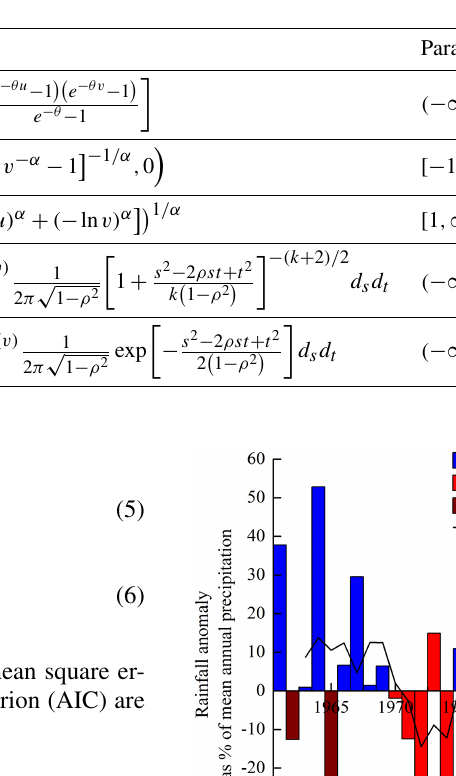
Table 2. Common two-dimensional copula function families.